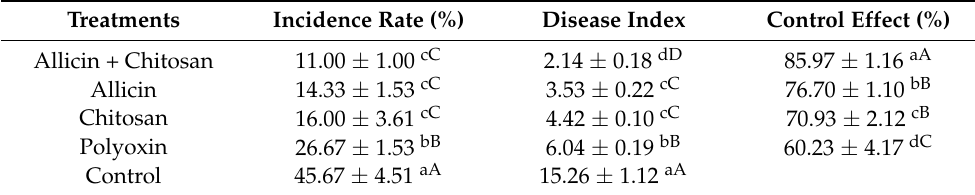
Table 3. The control effect of allicin and chitosan against powdery mildew of R. roxburghii